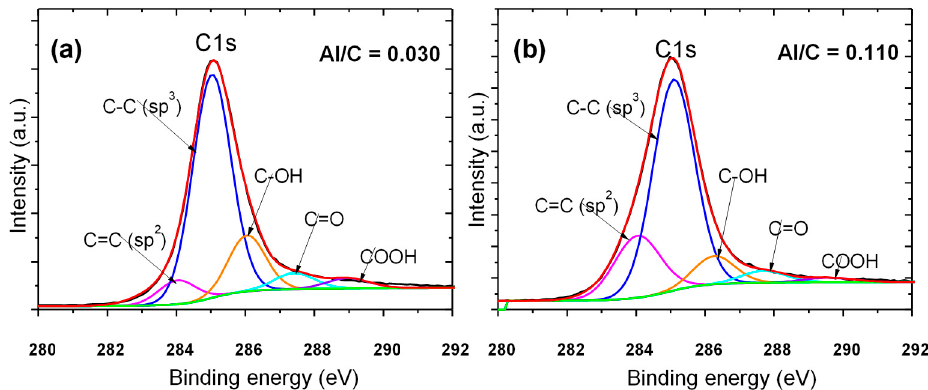
Figure 5. Ti2p XPS spectra of Ti-DLC coatings for Ti/C = 0.035.